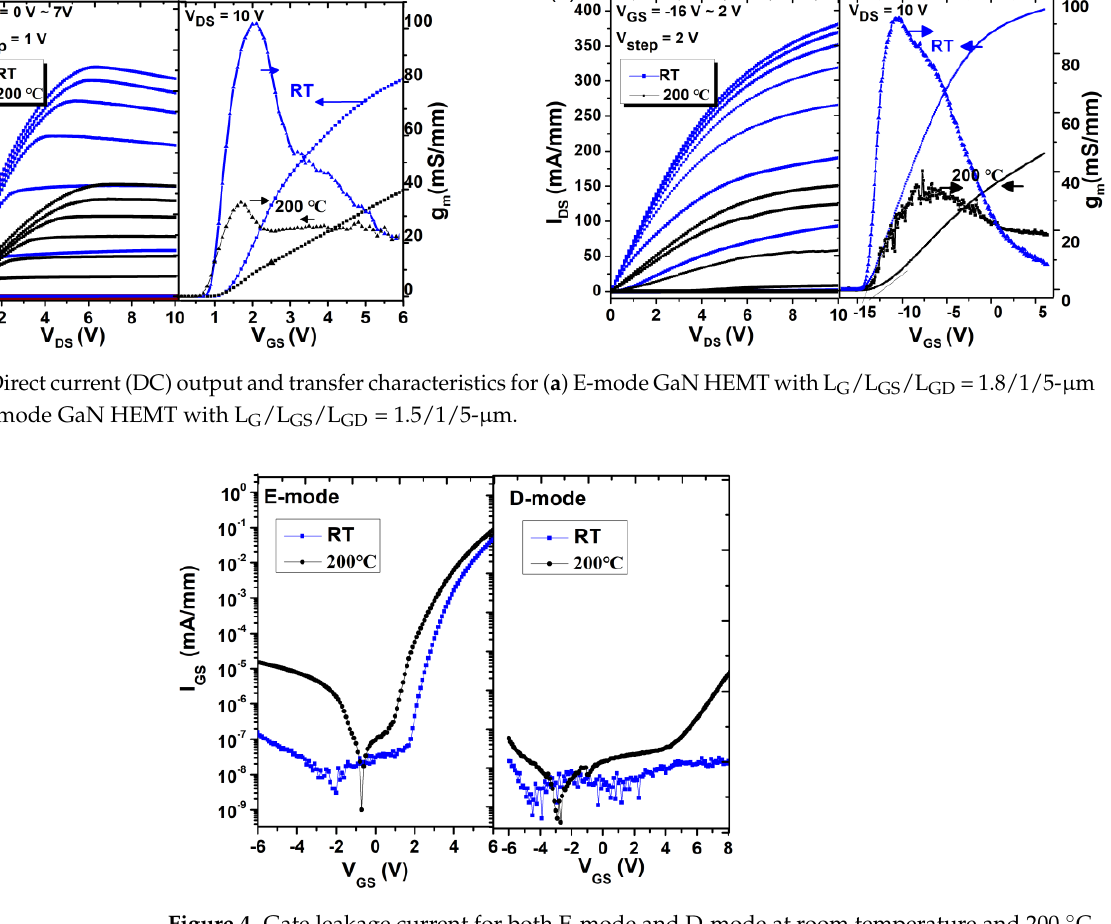
Figure 4. Gate leakage current for both E-mode and D-mode at room temperature and 200